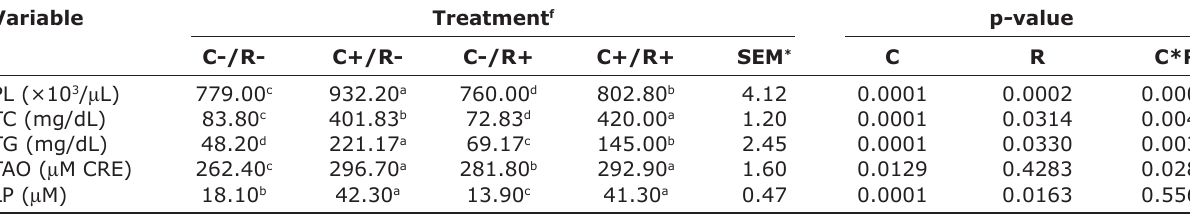
Table-2: Hematological responses of HC rats treated with resveratrol under HS e .